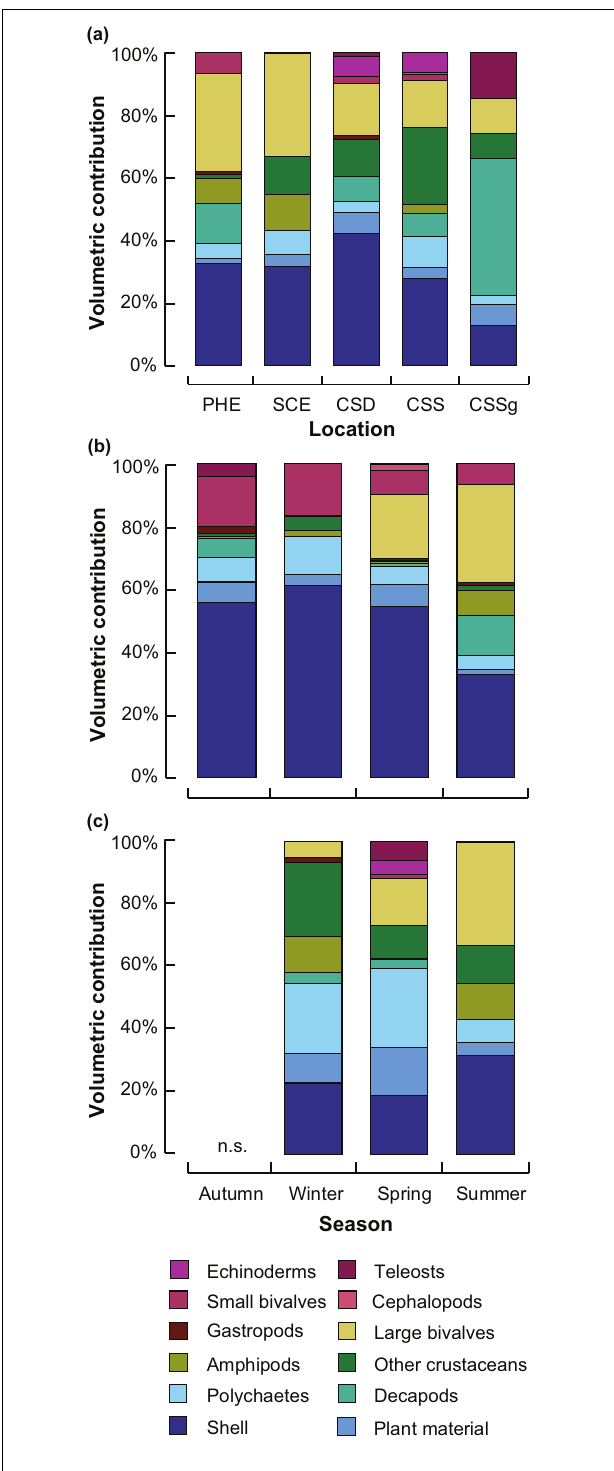
FIGURE 2 | Stacked bar graphs showing the mean percentage volumetric contribution of the predominant prey categories to the dietary composition of Portunus armatus in (a) each location in the Austral summer and each season within the (b) Peel-Harvey (PHE) and (c) Swan-Canning (SCE) estuaries. CSD = Cockburn Sound Deep sand; CSS = Cockburn Sound Shallow sand; CSSg = Cockburn Sound Seagrass. n.s. = not